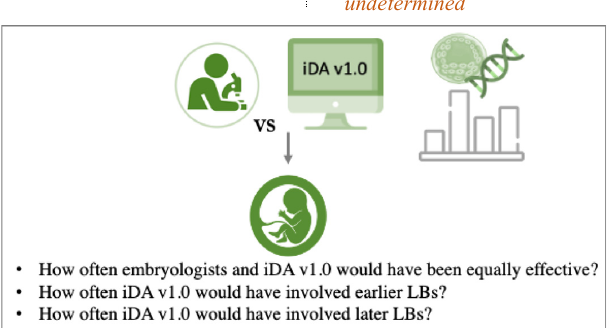
Figure 2. Clinical utility study workflow. ( A ) Definition of top-quality blastocysts within each cohort according to the embryologists versus iDAScore v1.0: how often were they euploid and how often aneuploid? ( B ) Definition of top-quality euploid blastocysts within each cohort according to